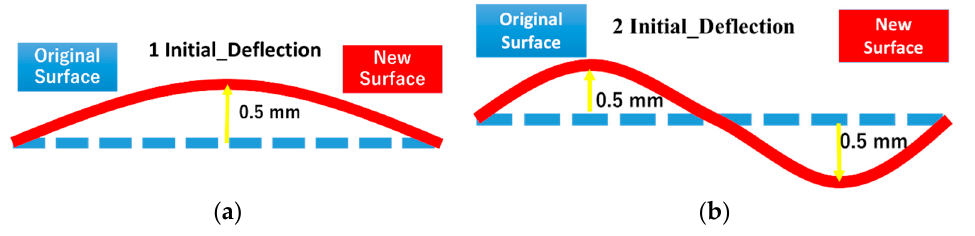
Figure 17. Two types of initial deflection: ( a ) arched type; ( b ) wavy type.